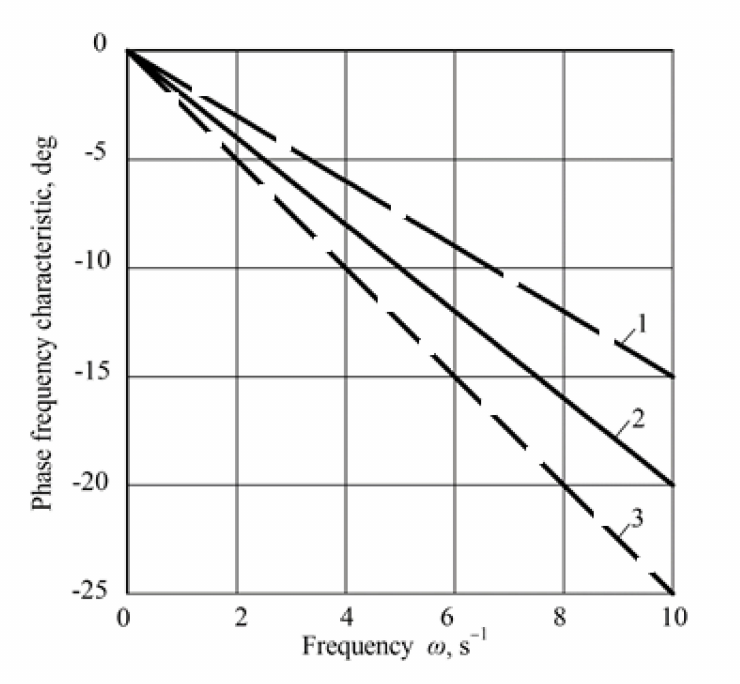
Figure 5. Phase-frequency characteristic of the tractor course angle ϕ when working out perturbations by it in the form of oscillations of the haulm harvester’s steering angle β at different unit movement speeds: 1— V o = 1.5 m · s − 1; 2— V o = 2.0 m · s − 1; 3— V o = 2.5 m · s −